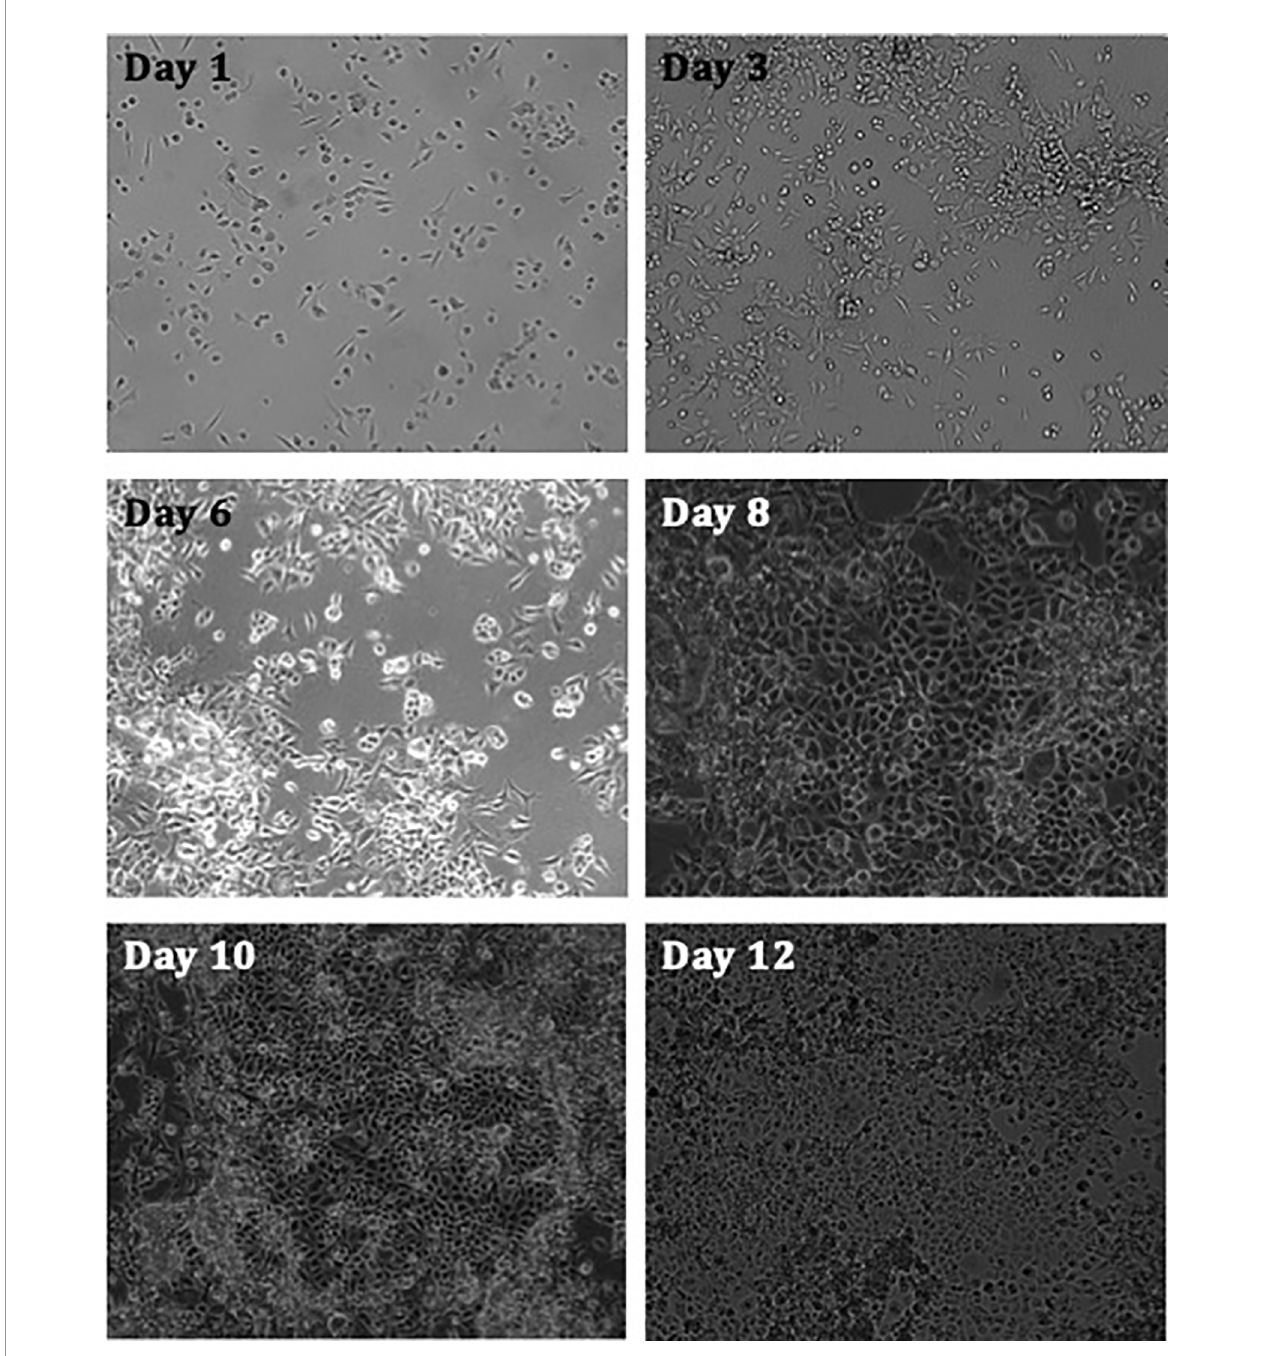
FIGURE 1 | Images taken of MPM cell culture MESO-163 (epithelioid MPM) seeded in 100% exudate MPM MPE fl uid only, at 100,000 cells per well in a 6-well plate. The images were taken on days 1-12 after seeding, and were taken at 10x magni fi cation [ZEISS Axiocam 506 mono]. The cells show increased levels of con fl uency with time. MPE, malignant pleural effusion; MPM, malignant pleural